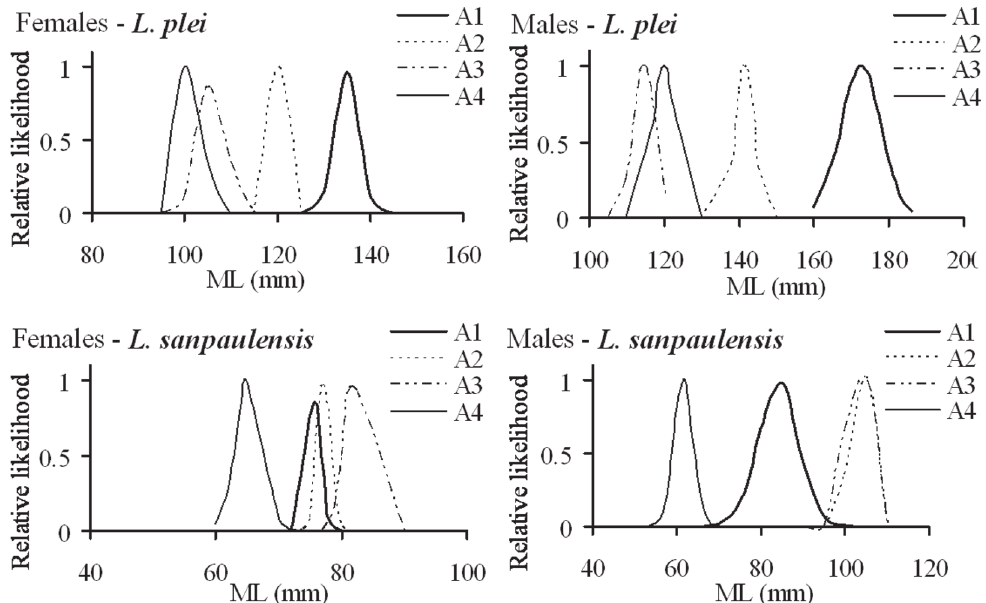
Fig. 5 . – Likelihood profiles showing differences between mean mantle length (mm) at different depth strata (A1, A2, A3 and A4) for males and females of L. plei and L. sanpaulensis . Depth strata are those presented in Fig. 4. Table 3. – Results of the ANOVA test for differences in GSI between months for L. plei and L . sanpaulensis data sets. Species